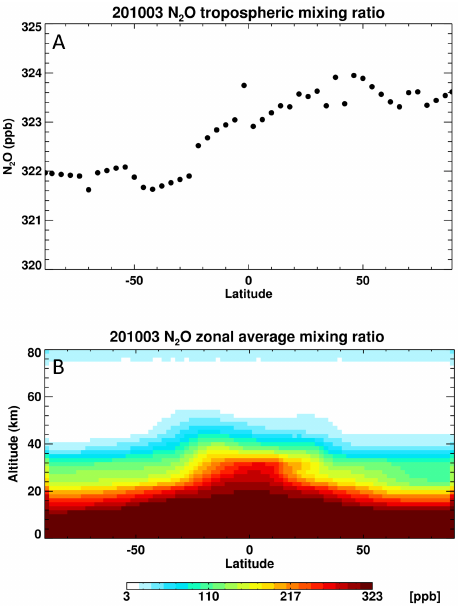
Figure 2. Initial model N 2 O field for March 2010. Shown are the (a) tropospheric N 2 O mixing ratios, and (b) zonal mixing ratio cross